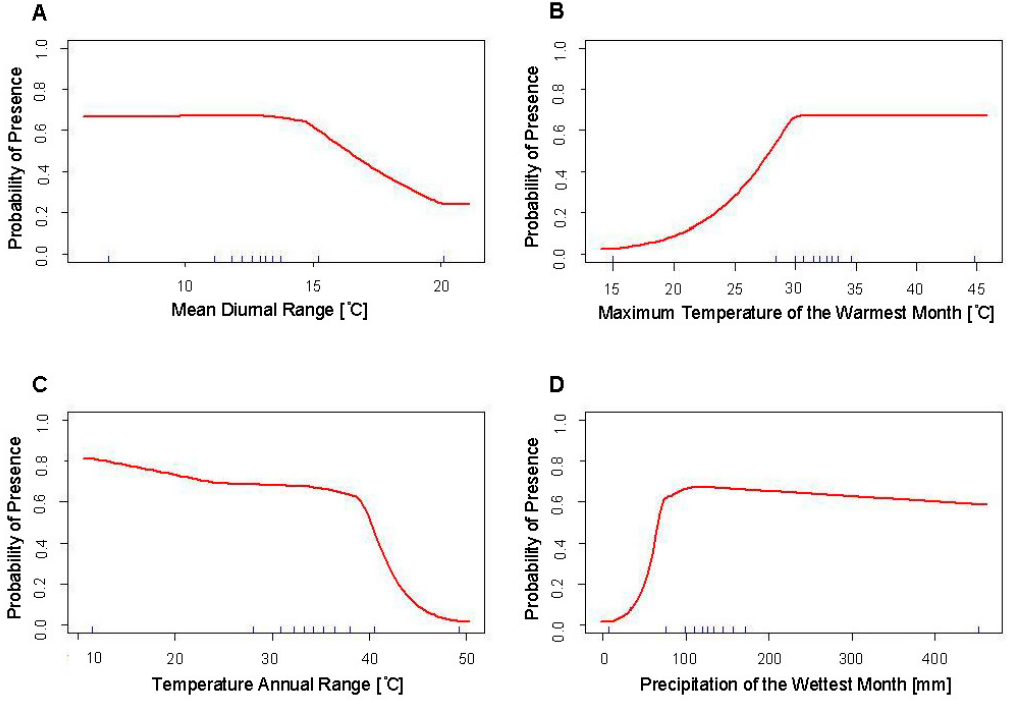
Figure 3. Response curves of the variables used in the final SDMs of Ae. albopictus (Model 1b) using all occurrence records showing predicted habitat suitability to ( A ) mean diurnal range (Bio2), ( B ) maximum temperature of the warmest month (Bio5), ( C ) temperature annual range (Bio7), and ( D ) precipitation of the wettest month (Bio13).